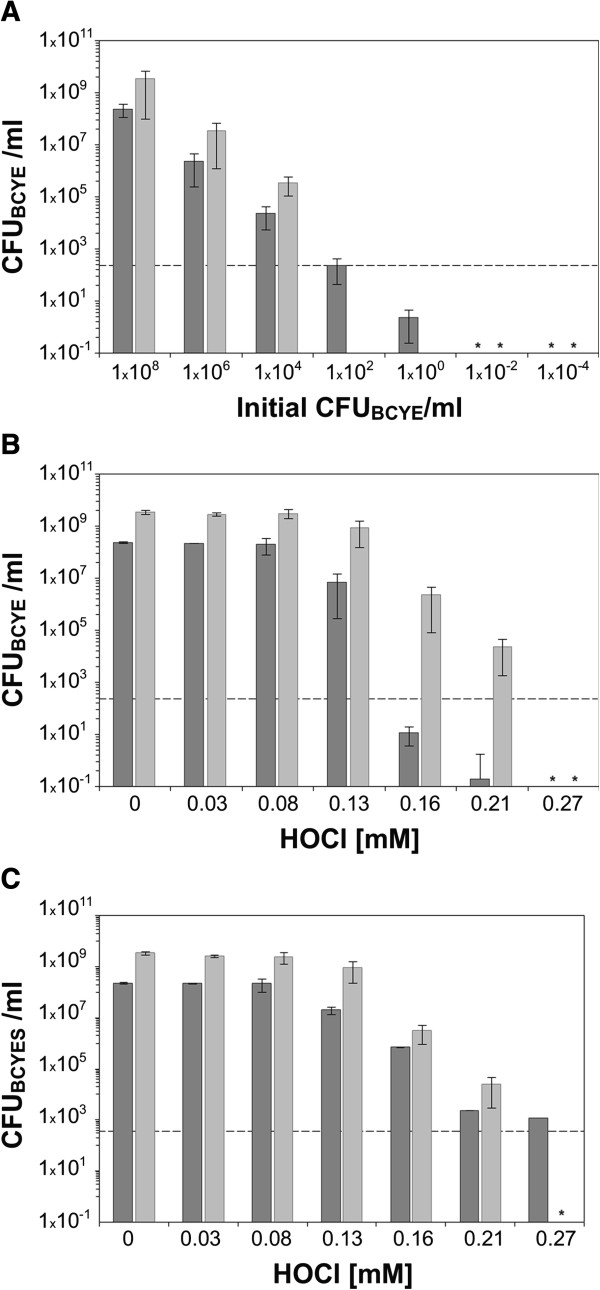
Proliferation of Legionella cells in co-culture with A. castellanii. (A) Proliferation of serially diluted culturable cells is represented as a function of the initial number of CFU as assessed on the standard medium (BCYE). (B & C) Proliferation of cell suspensions exposed to various concentrations of HOCl based on the initial number of CFU as assessed on the standard medium (BCYE) (B) or the supplemented medium (BCYES) (C). Dark bars represent the initial number of CFU as assessed on the standard medium or the supplemented medium (BCYES). Gray bars represent the number of CFU as assessed on the BCYE medium after co-incubation with axenic culture of A. castellanii. The values reported are means for duplicate samples in three independent experiments. Error bars indicate SD and asterisks values below the detection limit (<0.1 CFU.ml-1).